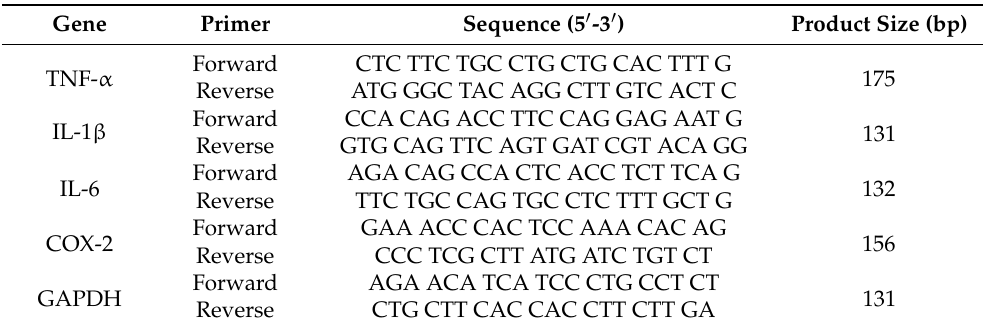
Table 1. Primer sequences of TNF- α , IL-1 β , IL-6, COX-2, and GAPDH used in qPCR. The product sizes generated by each primer set are also